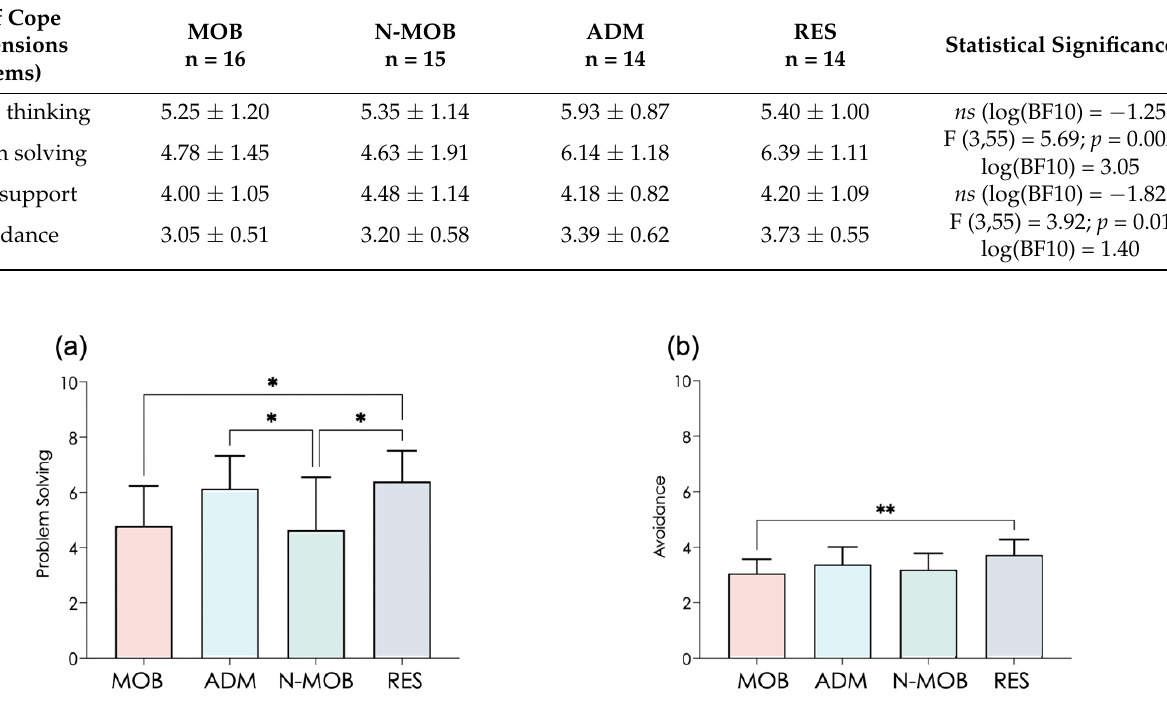
Figure 2. Scores on the two factors of the Brief-COPE variables significantly different between subjects (see Table 2), Problem Solving ( a ) and Avoidance ( b ). MOB, mobilized healthcare workers; ADM, administrative staff; N-MOB, healthcare professionals who had not been mobilized; and RES, researchers and teachers from the University. Error bars represent the standard deviation. * p < 0.05; ** p < 0.01.